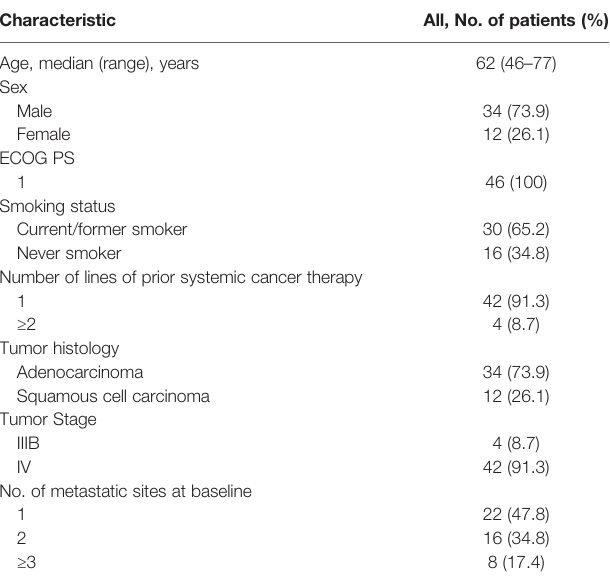
TABLE 1 | Baseline patient characteristics (N =